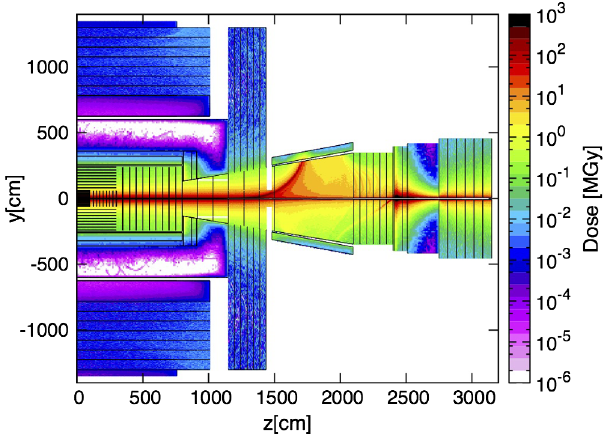
FIG. 12. Dose for an integrated luminosity of 30 ab − 1 : lateral view. A dedicated scoring resolution has been used for the different subdetectors, adapted to their specific